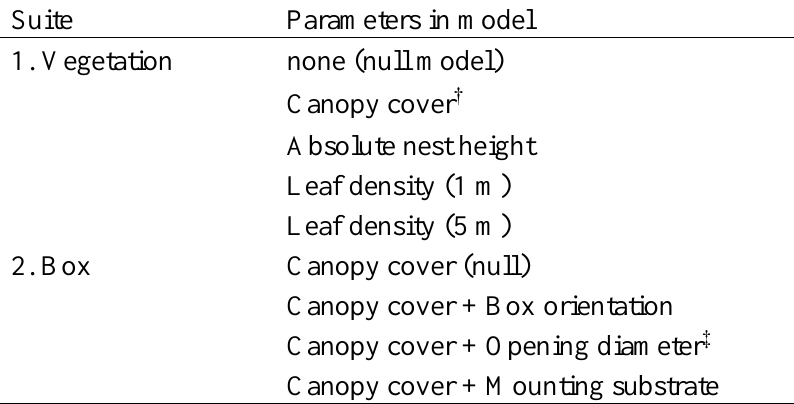
Table A1.2. List of suites built for hierarchical model selection analyzing habitat selection process of Prothonotary Warblers nesting in nest boxes in White River National Wildlife Refuge, Arkansas, USA in 2015 only. Each model was a generalized linear model with the binomial dependent variable of used (boxes that were nested in) versus unused (boxes that were never nested in). The top model of each suite ( † ) was carried on to the next suite as the new suite's null model, and parameters from this model were added to the new suite's models. If no model was better than the null model, the null model was carried on to the next suite. In the text, we report the parameters of the final top model or models ( ‡ ). All models were built and compared in Program